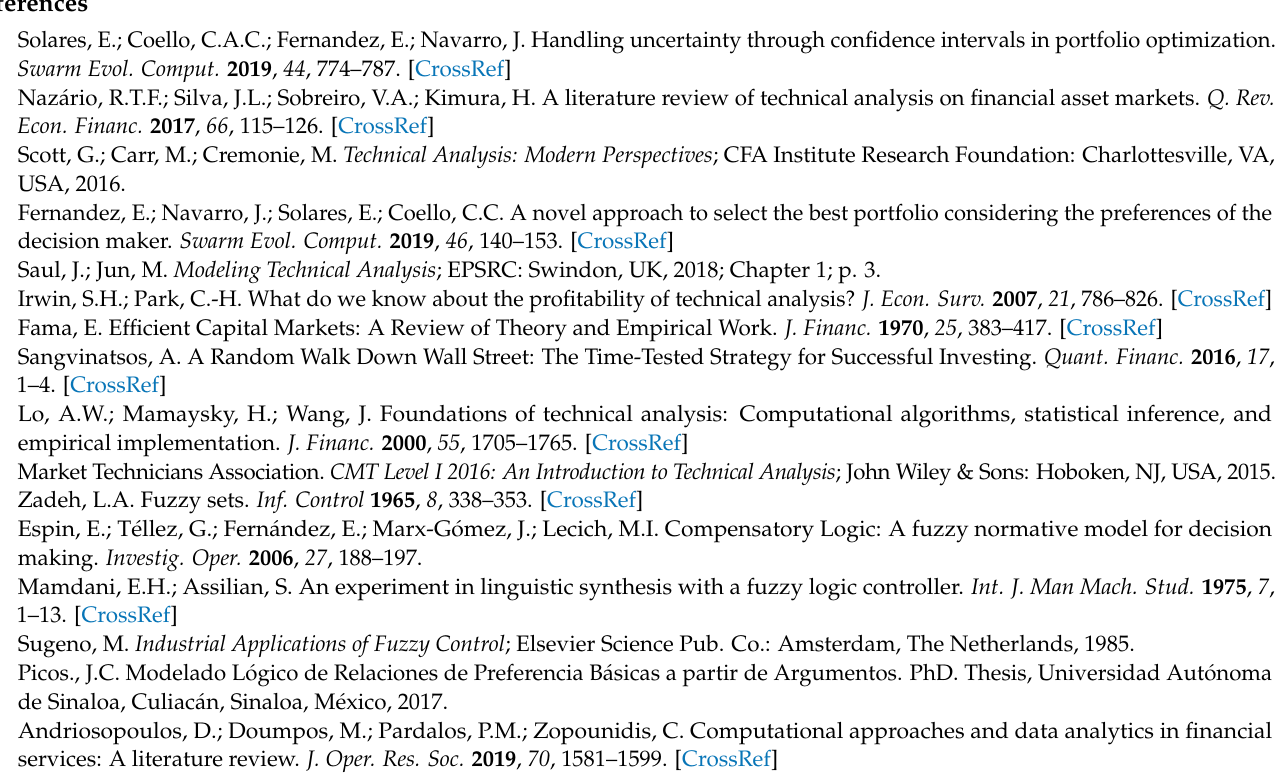
moving average. curve